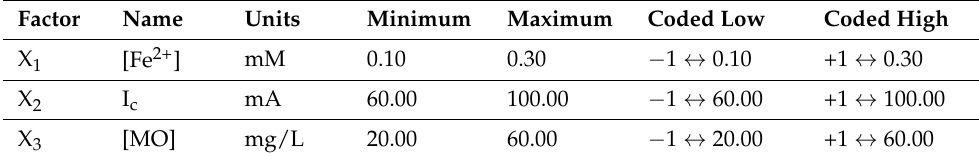
Table 3. Limitations of the BBD plan factors.